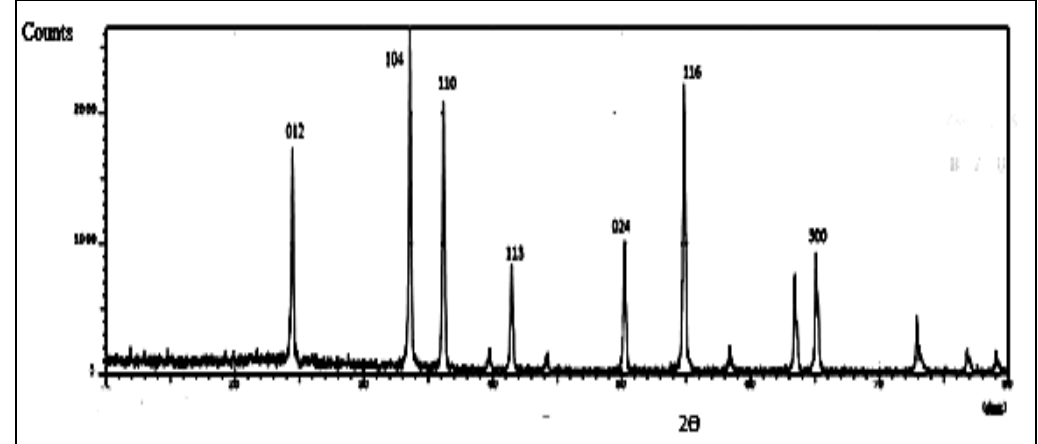
Table 1: Experimental and standard values of peaks, and grain size of Cr